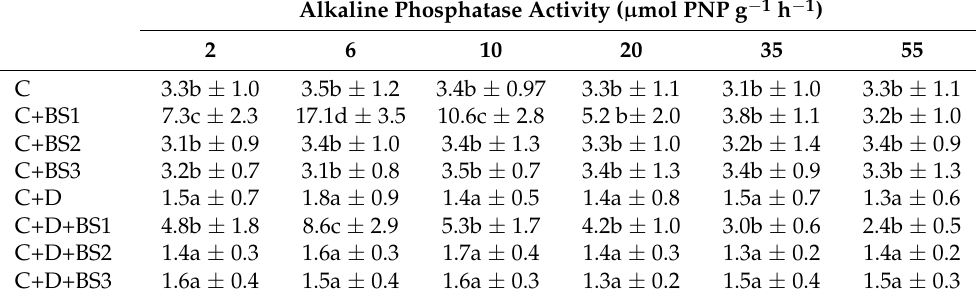
Table 4. Evolution of alkaline phosphatase activity (mean ± standard error, n = 3) in soils amended with the three experimental biostimulants and polluted with diuron during the experimental